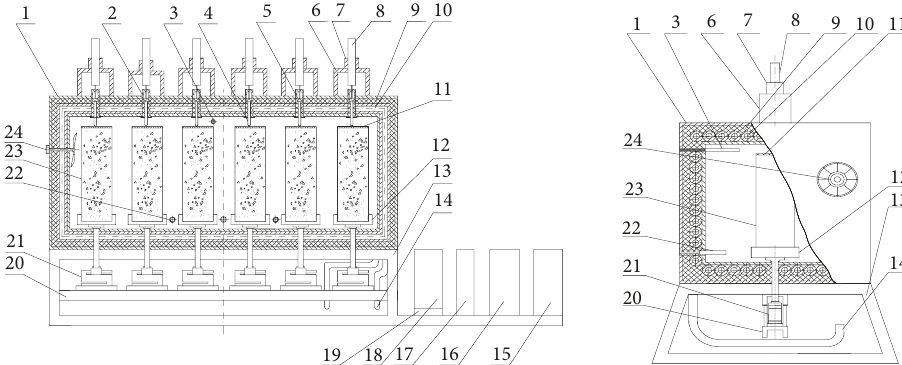
Figure 2: Components of the Material Deformation Tester.